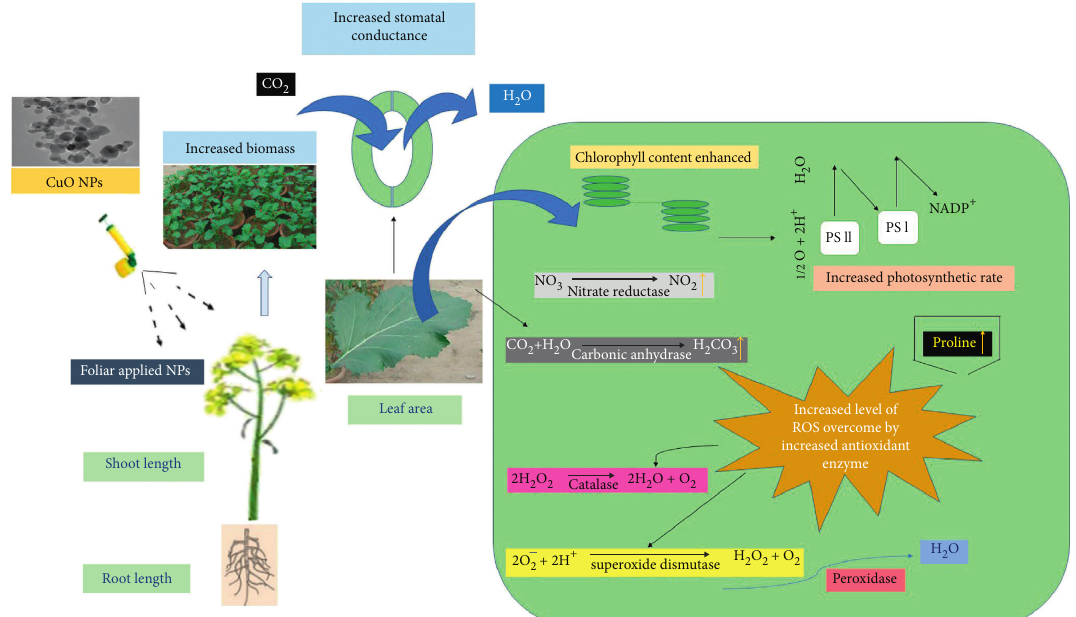
Figure 5: A simplified view of the foliar application of CuO NPs and their effect on the physiological and biochemical parameters in Brassica juncea